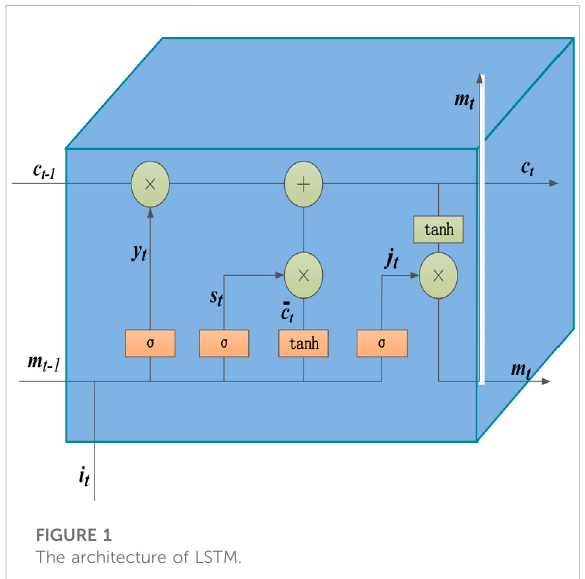
FIGURE 1 The architecture of LSTM.